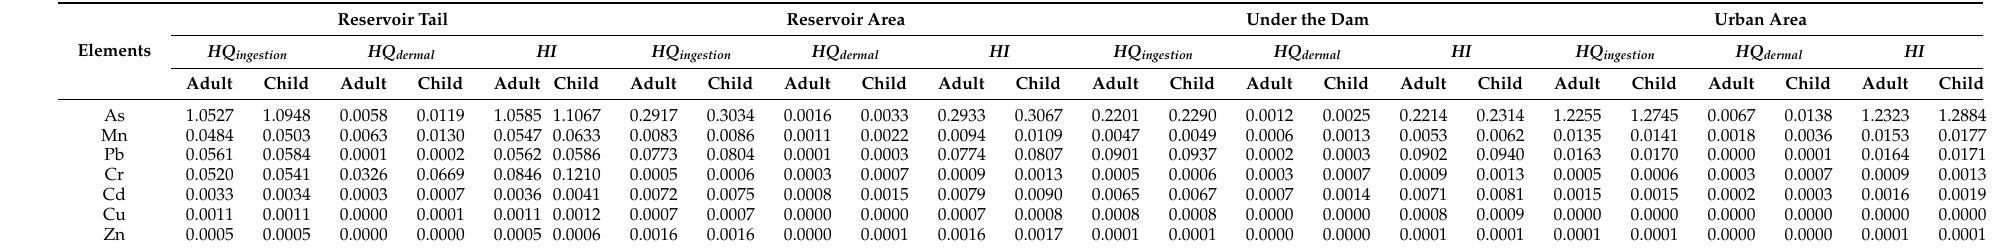
Table 6. Health-evaluation index of trace elements in the main stream of Lancang River during the wet season.